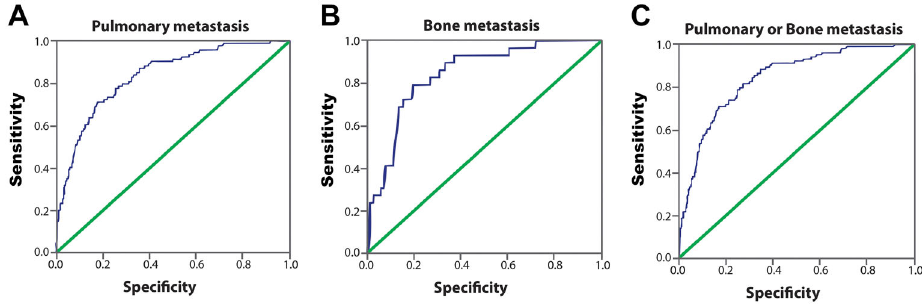
Figure 3. ROC of serum postoperative stimulated thyroglobulin (ps-Tg). ROC in identifying the presence of pulmonary metastasis ( A ), bone metastasis ( B ), and either pulmonary or bone metastasis ( C ). The area under the curve (AUC) for the ps-Tg level used for identifying metastasis was 0.836 (pulmonary), 0.847 (bone), and 0.845 (pulmonary or bone). Table 4. Ps-Tg values to identify distant metastases in patients with differentiated thyroid cancer. Metastasis